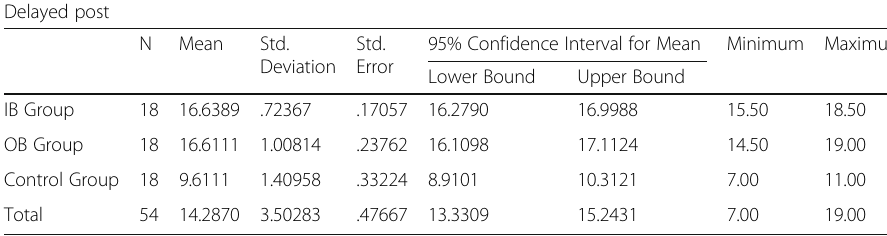
Table 7 Descriptive Statistics (delayed tests) Delayed